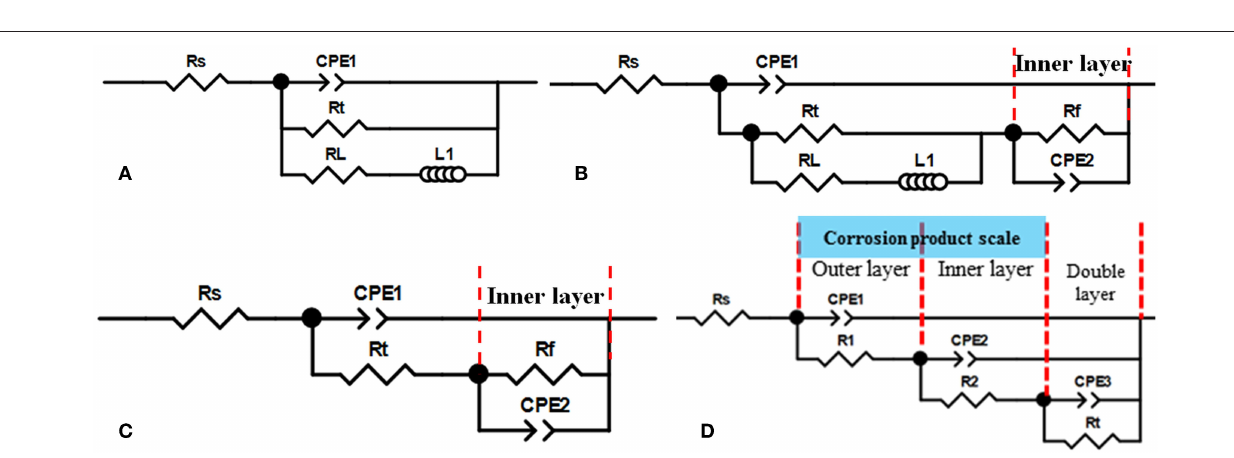
at 80 ◦ C, the slope of the LPR curves decreases initially but starts to increase significantly after 30 h ( Figure 4B ), and relatively high polarization resistance is found after extended immersion ( > 80 h). Figure 4C shows the representative LPR results of C1018 steel in the dilute NaCl solution (0.001%) maintained at 80 ◦ C. An initial decrease of polarization resistance up to 30 h is followed by a later increase, similar as those shown in